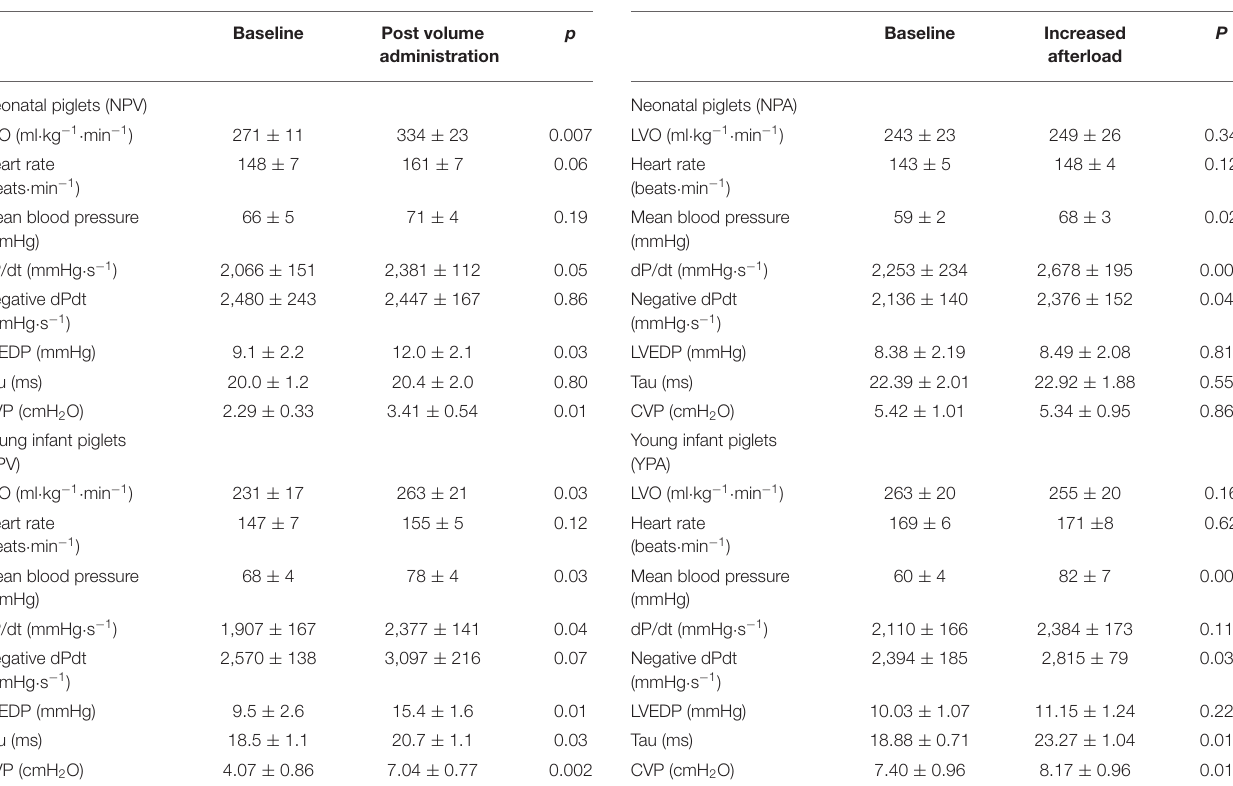
TABLE 2 | Effect of increasing preload. TABLE 3 | Effect of increasing